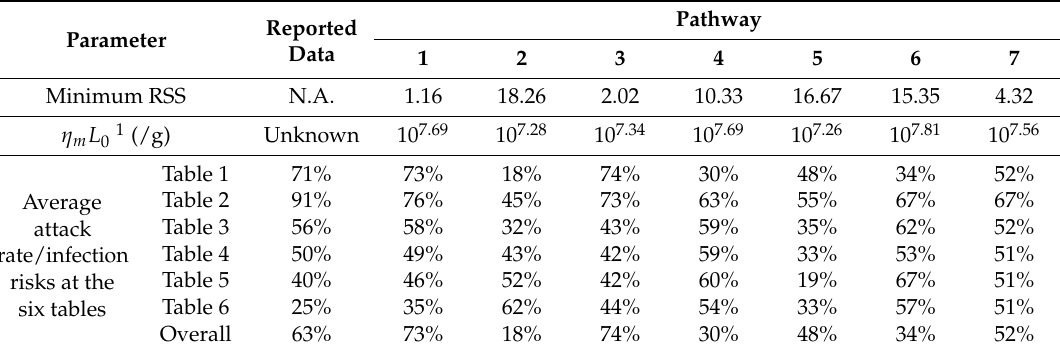
Figure 3. Fitness between the reported attack rates and predicted infection risks in different scenarios, using different values for the products of viral load and the dose-response parameter on mucous membranes, η m L 0 (10 5 –10 9 /g). The fitness is inversely proportional to the value of the residual sum of squares (RSS) and is thus represented by (RSS) − 1 . Seven types of serving pathways are marked with seven colored lines. The orange dotted line indicates the baseline condition, where η m = 0.1415/genome copy and L 0 = 3 × 10 8 genome copies/g. Table 1. Comparison of the reported attack rates and predicted infection risks with the best fitness (minimum residual sum of squares, RSS) for the seven types of waiters’ serving pathways. The scenarios with the best fitness correspond to the highest points of the curves in Figure